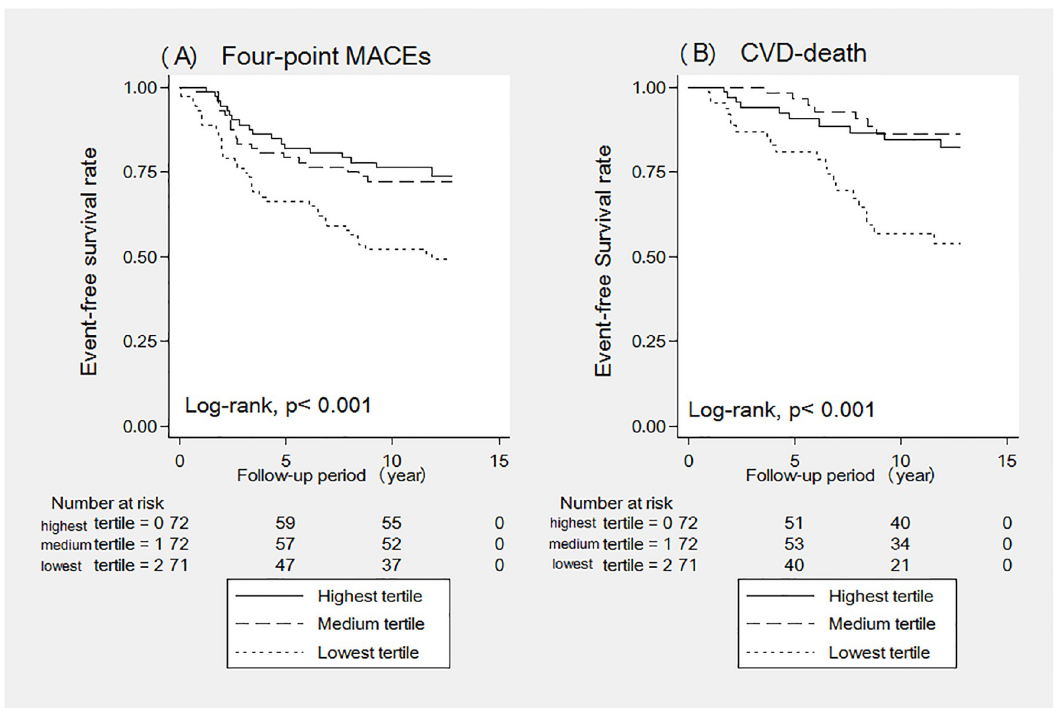
Fig 1. (A and B). Cumulative event-free survival for 4-point MACEs, and CVD-death according to the lowest, medium, and highest relative CD34 + cell